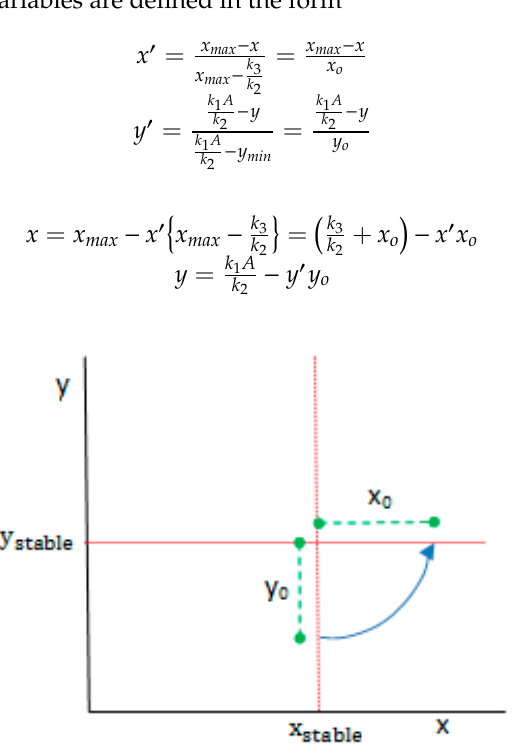
Figure 5. Starting and ending position of the path of the fourth quadrant.